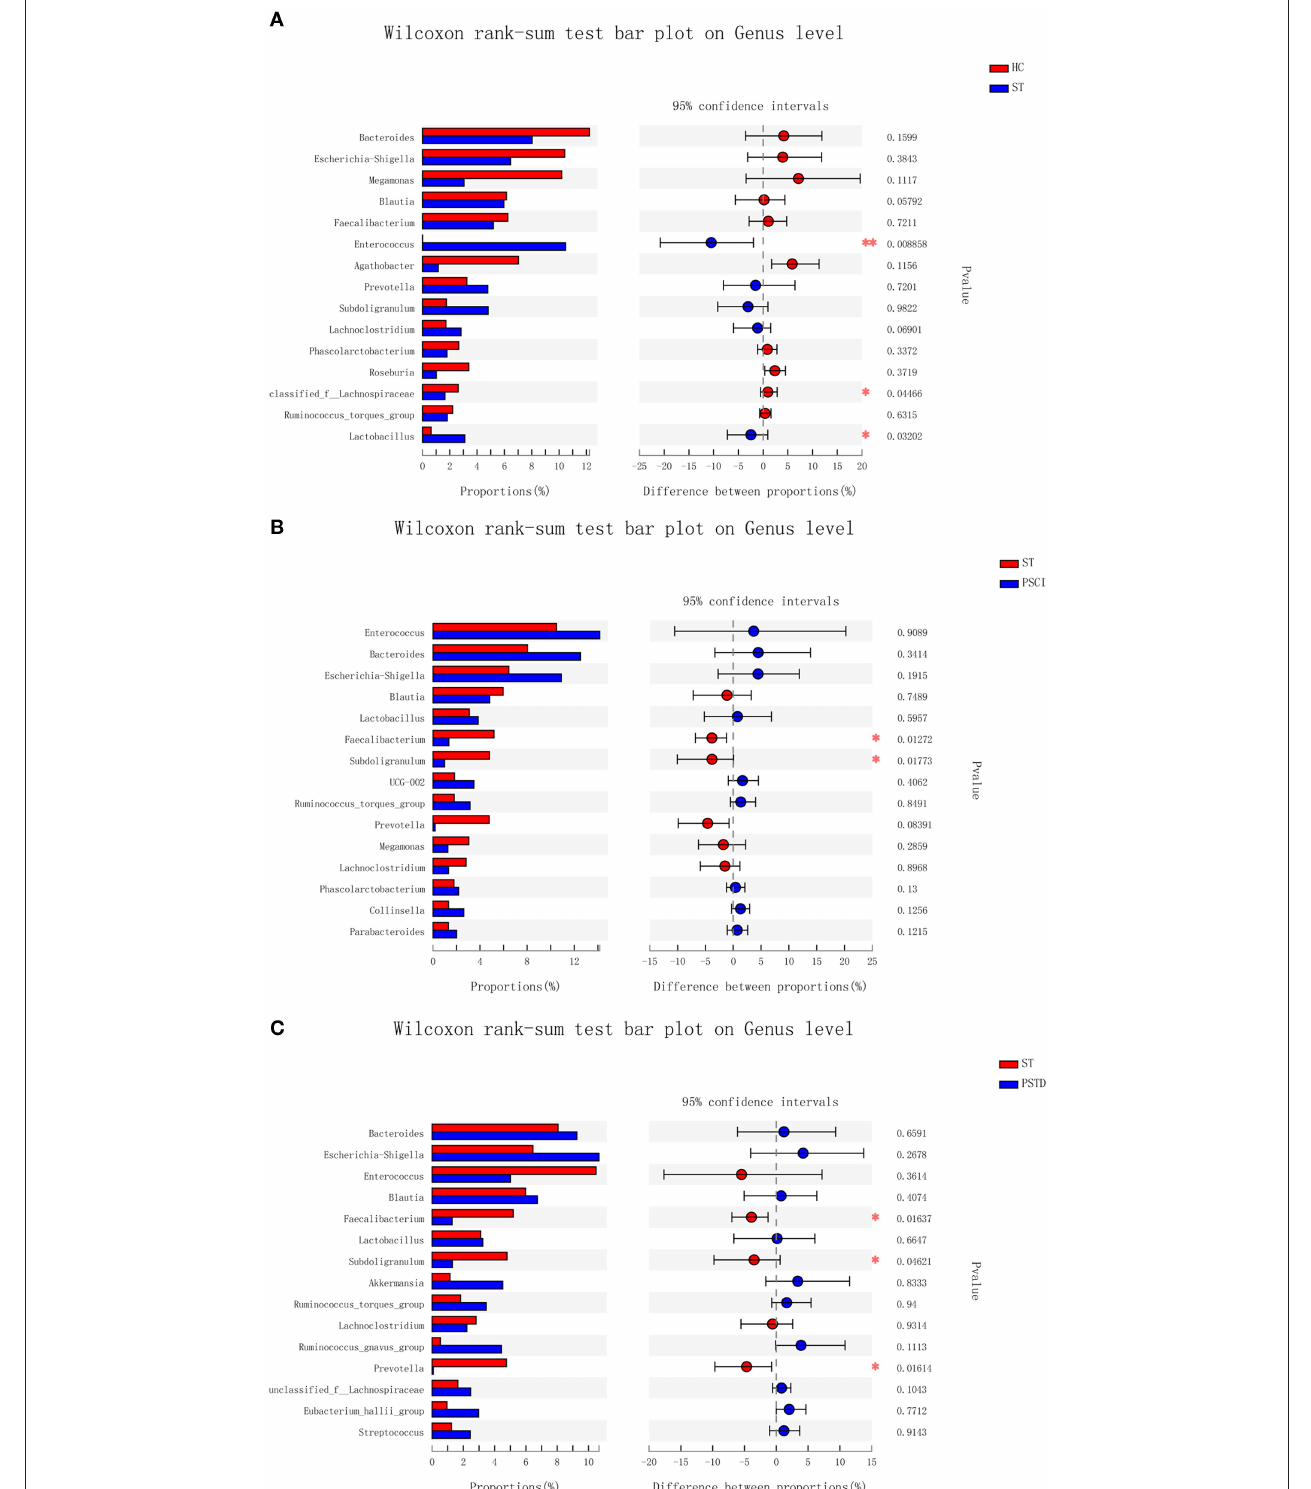
FIGURE 5 | Bar charts of multi-species difference. (A) ST vs. HC, (B) PSCI vs. ST, (C) PSTD vs. ST. *0.01 < p < 0.05, **0.001 < p < 0.01.